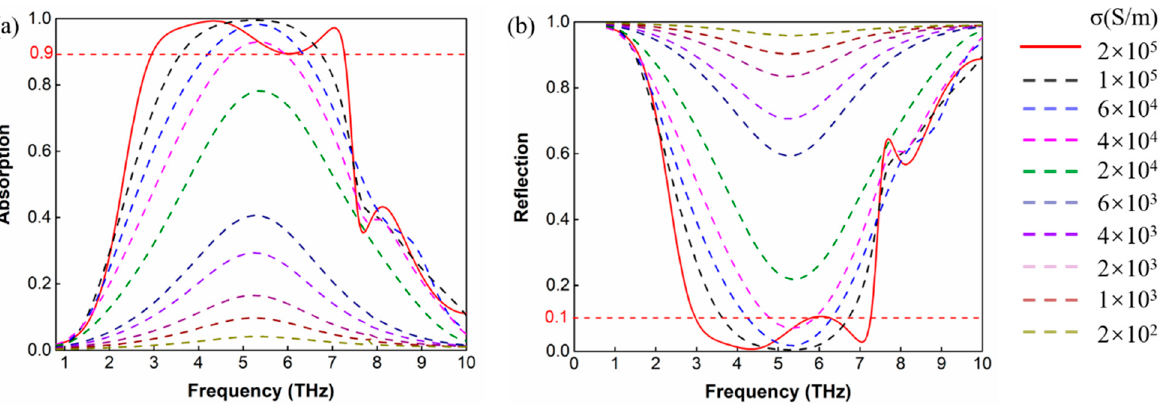
Figure 2. ( a ) Optimal absorption and reflection spectrum and ( b ) absorption spectrum at different polarization angles when σ = 2 × 10 5 S/m.